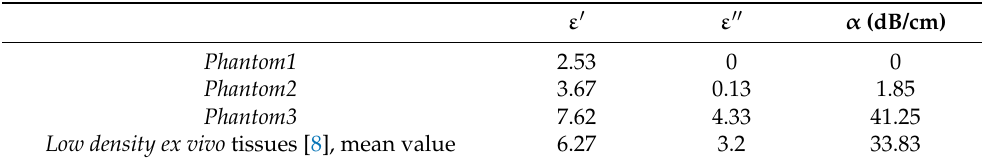
Table 2. Dielectric Properties of the Produced Phantoms @ 30